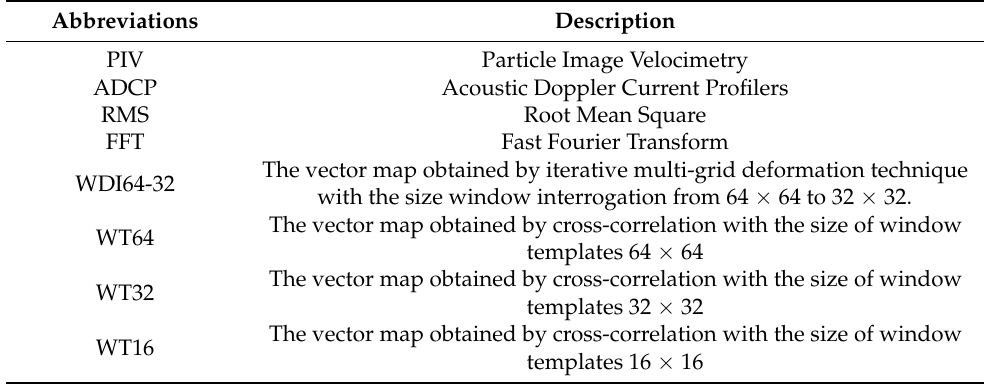
Table A1. The descriptions of abbreviations in the